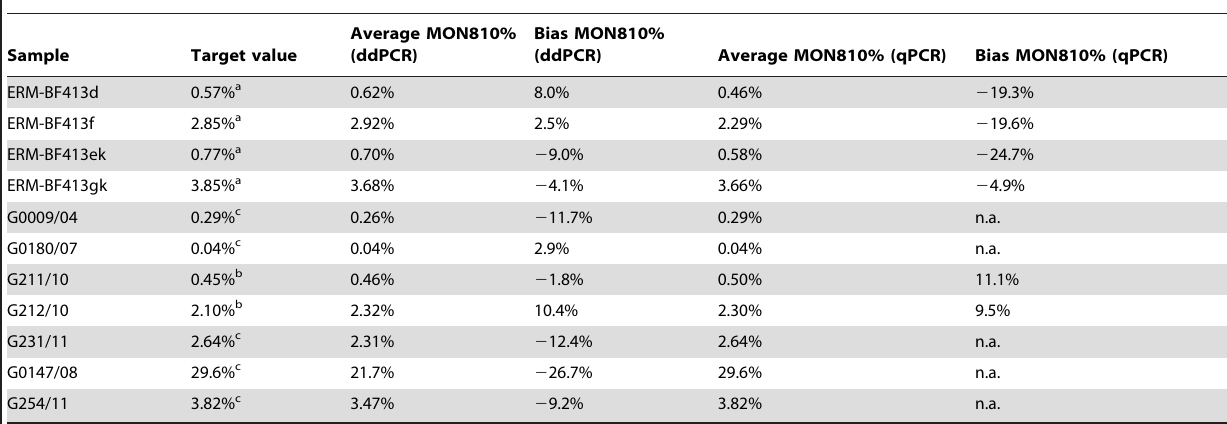
Table 1. Application of the ddPCR duplex assay on different sample matrices.